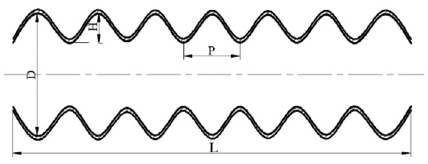
Figure 2. Diagram of corrugated pipe.